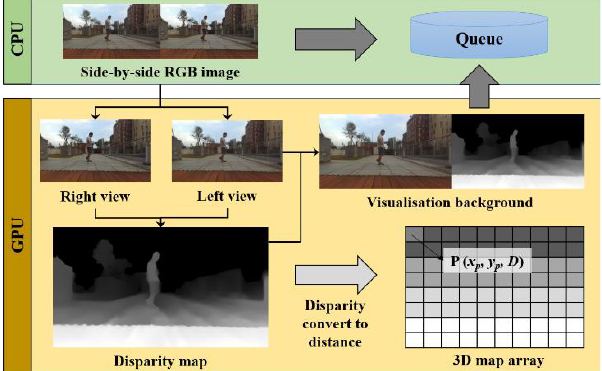
Figure 2. Dense image matching and triangulation processing